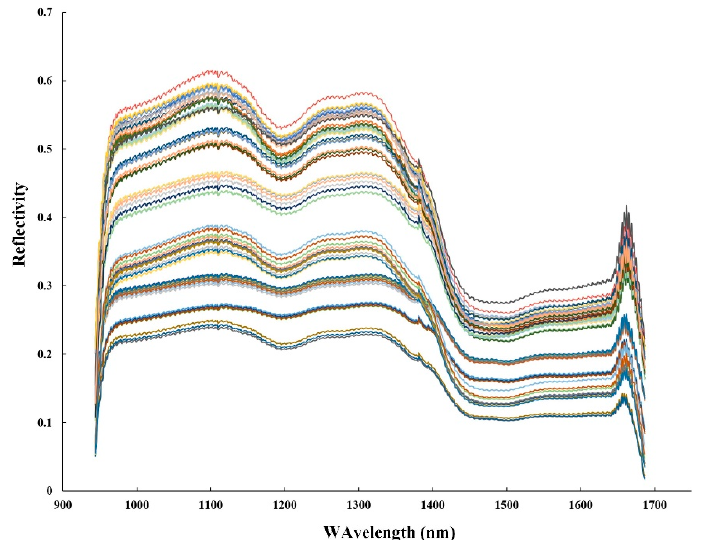
Figure 5. Hyperspectral images of three tea categories including black tea, green tea, and yellow tea.